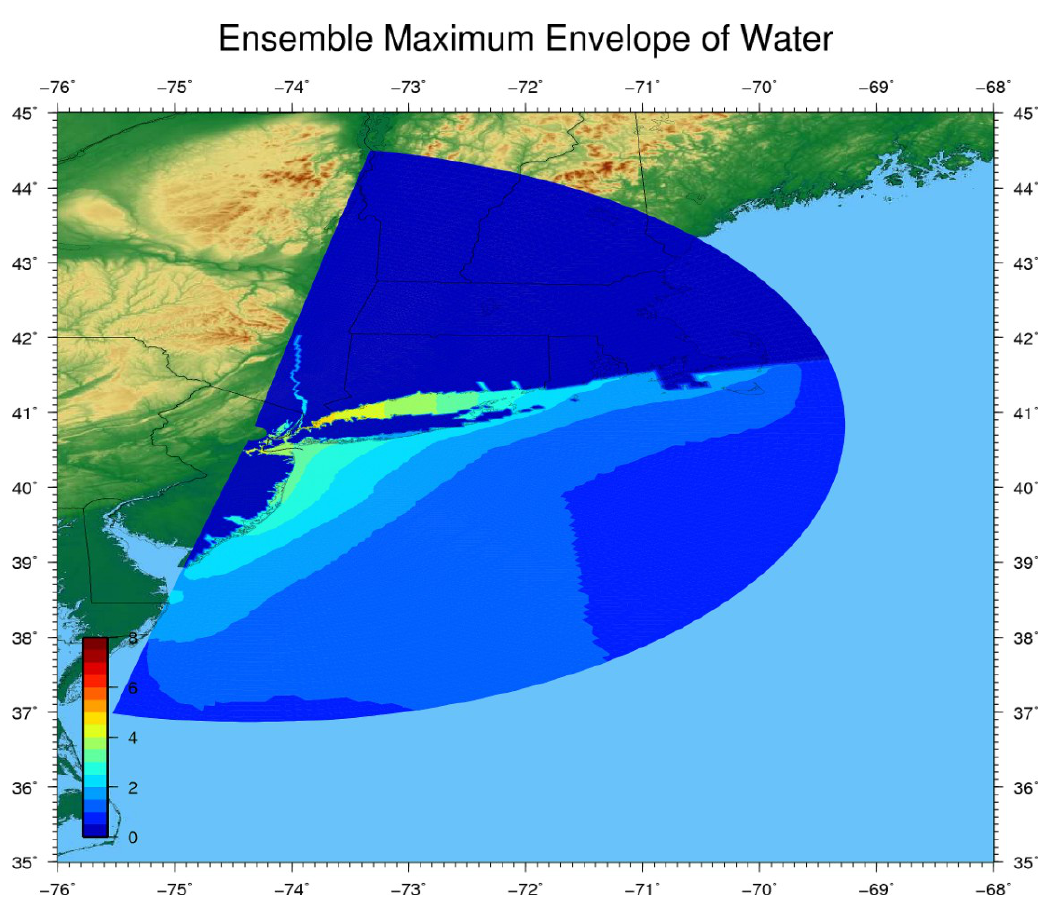
Figure 6. Ensemble maximum envelope of water (m) 48 h prior to landfall with a maximum total water level of 4.94 m (16.2 ft) relative to the NAVD88 vertical datum.